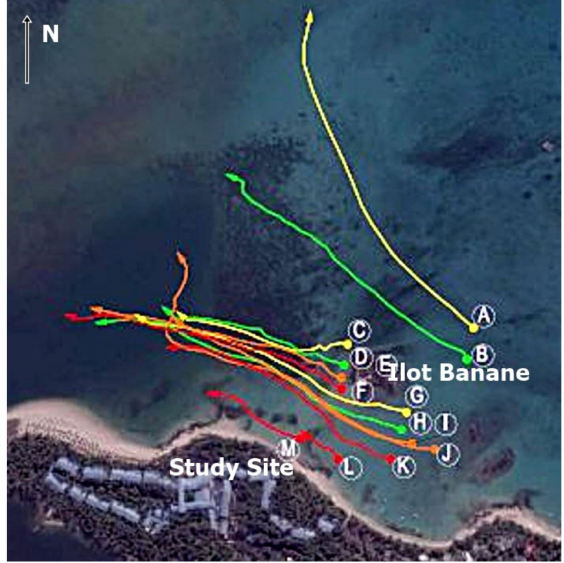
Figure 10. Typical drogue paths at the study site.